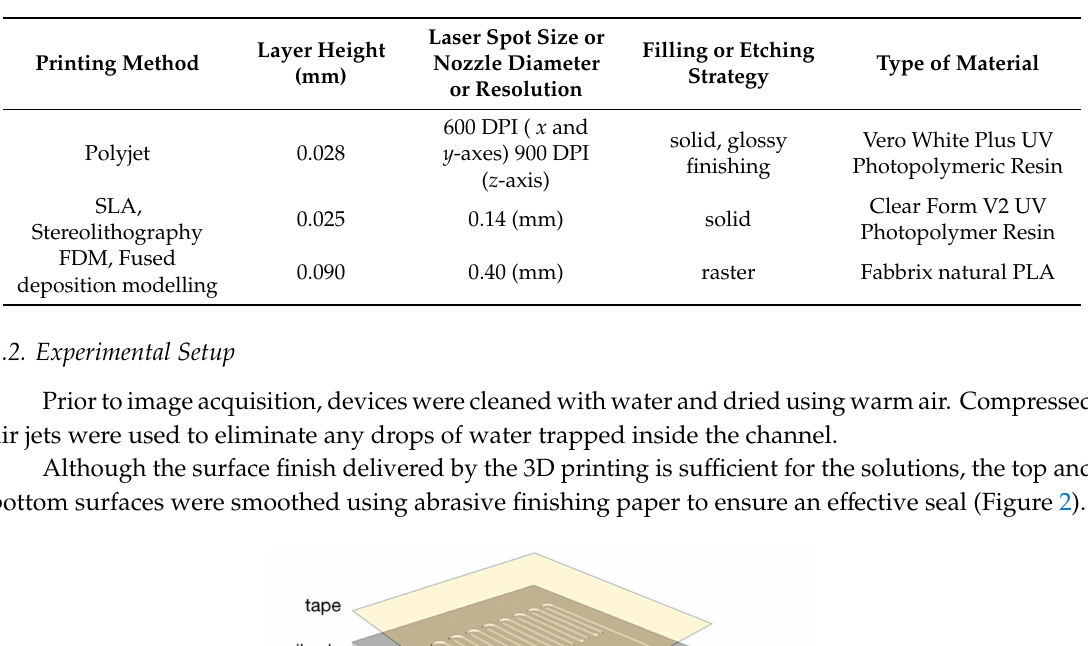
Figure 1. ( a ) Computer-assisted design (CAD) drawing of the designed micro-mixer with dimensions in mm; ( b ) 3D model of unibody passive micro-mixer. Table 1. Process parameters and materials used for the fabrication of the micro-mixers.